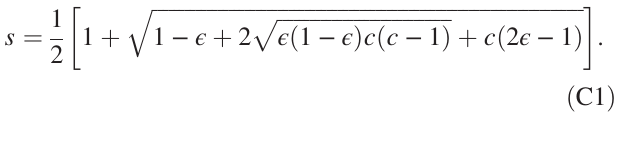
ffiffiffiffiffiffiffiffiffiffiffiffiffiffiffiffiffiffiffiffiffiffiffiffiffiffiffiffiffiffiffiffi p ϵ ð 1 − ϵ Þ c ð c − 1 Þ